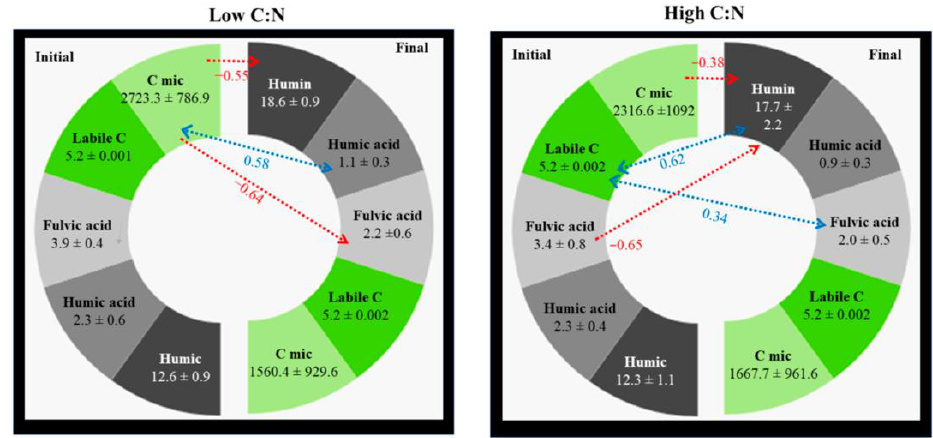
Figure 5. Routes of humin (g kg −1 ), fulvic acid (g kg −1 ), humic acid (g kg −1 ), labile carbon (g kg −1 ), and microbial biomass carbon (C mic, μg g −1 ha −1 ) between the initial (1 – 6th day of incubation) and final period (7 – 50th day of incubation). Negative and positive routes are demonstrated by red and blue arrows, respectively.